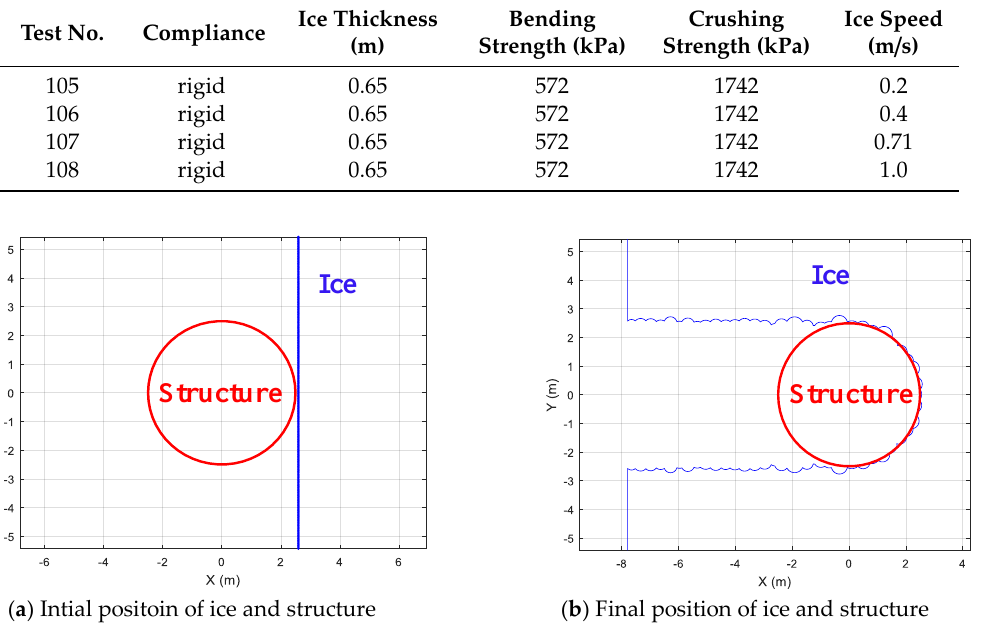
Figure 8. Initial and final ice boundaries.